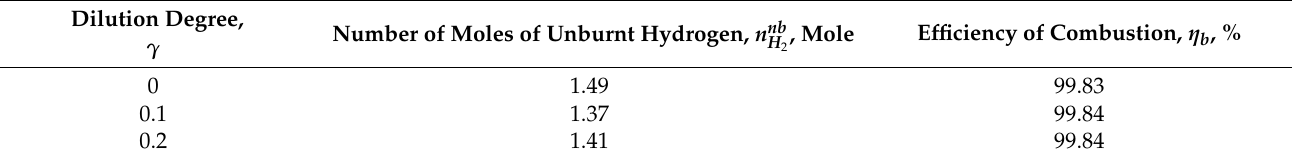
Table 5. Dependence of combustion efficiency on degree of dilution with the water